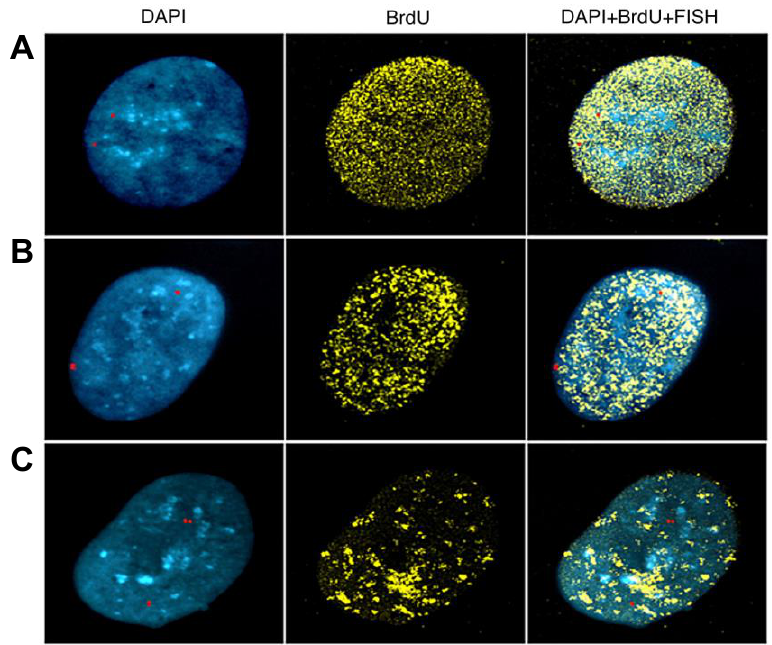
Figure 4. Bromodeoxyuridine (BrdU) replication labelling on interphase nuclei from early, mid, and late S-phases. Example of nuclei stained with DAPI, FISH (red), and BrdU as indicated, and merge (right) of early ( A ), mid ( B ), and late S-phase stages ( C ), as plotted in Figures 5 and 6.